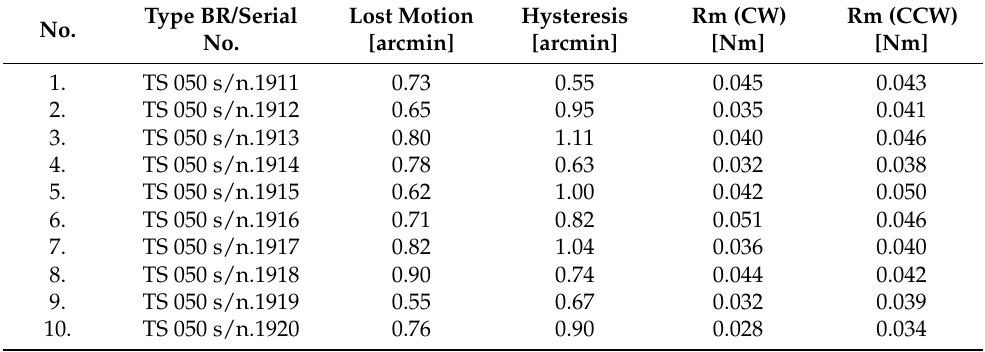
Table 7. Bearing reducer TS 050 parameters measured before the trial run (configuration B).